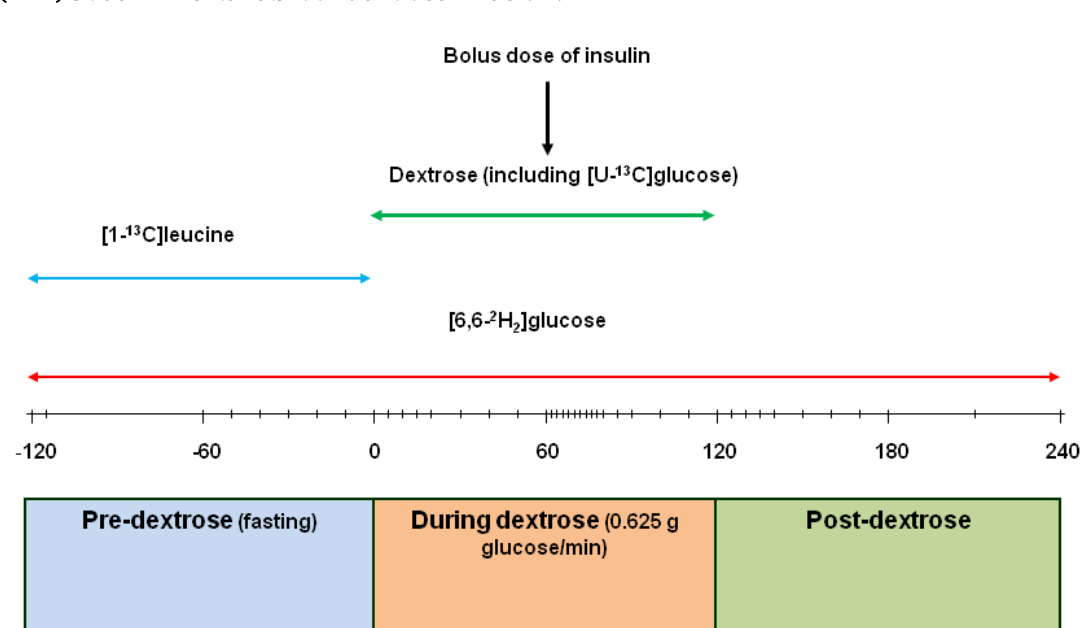
Figure 1. Time line (min) of the various infusions on the last day of each dietary period. The vertical dashes on the time line indicate sampling points. The [1- 13 C]leucine and [6,6- 2 H ]glucose were infused at tracer amounts, while the dextrose infusion represents 2 a 75 g glucose challenge infused over 2 h. Insulin was injected at 0.04 IU/kg body weight (BW) at 60 min after start of dextrose